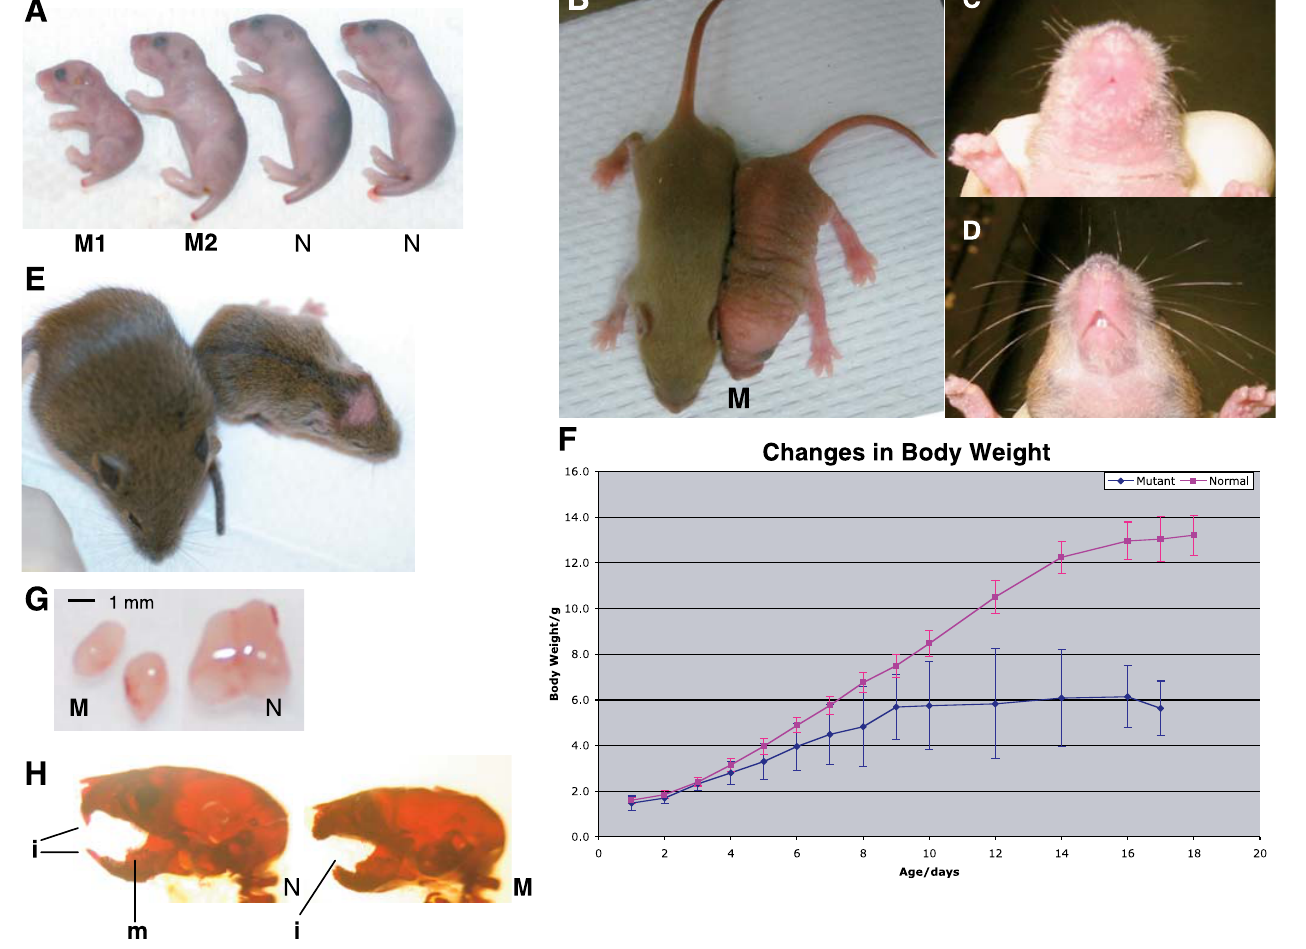
(A) Two P3 mutant mice, M1 and M2, and their normal littermates, showing size variation among mutants. (B) P8 mutant mouse (right) and a normal littermate. Note sparseness of hair coat and abnormal ears. (C–D) Vibrissae of whisker pads are short and oddly angled in a P12 mutant mouse (C), relative to control (D). Note the lack of incisors in the mutant. (E) A P17 mutant mouse (right) with its littermate. Its bare forehead, dorsal median line, and abnormal ears are evident. (F) Growth curve of mutants and normal littermates. Mutants exhibit stunted growth, which became more prominent as they aged, and weigh significantly less than littermates from P8 ( p , 0.05). (G) Comparison of mutant and normal thymus from P3 mice. The mutant thymus (left) is dramatically smaller for its age compared to the normal littermate (right). The scale bar equals 1 mm. (H) Skeletal preparations of normal (left) and mutant (right), showing differences in development of both incisor (I) and molar (M) teeth. DOI: